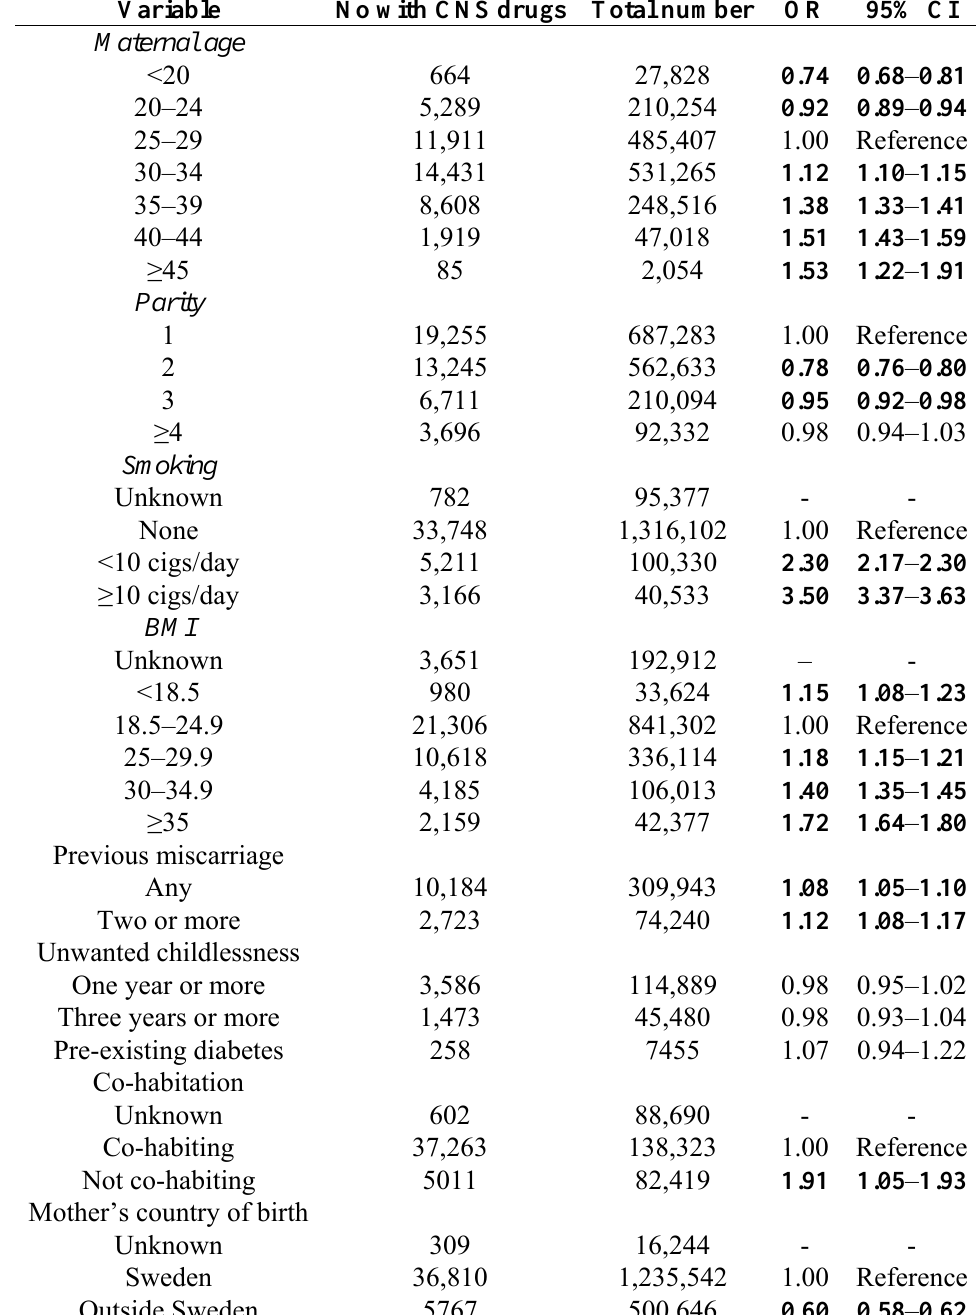
Table 2. Characteristics of women using CNS active drugs in early pregnancy. Each variable is adjusted for the other variables. Bold text marks statistical